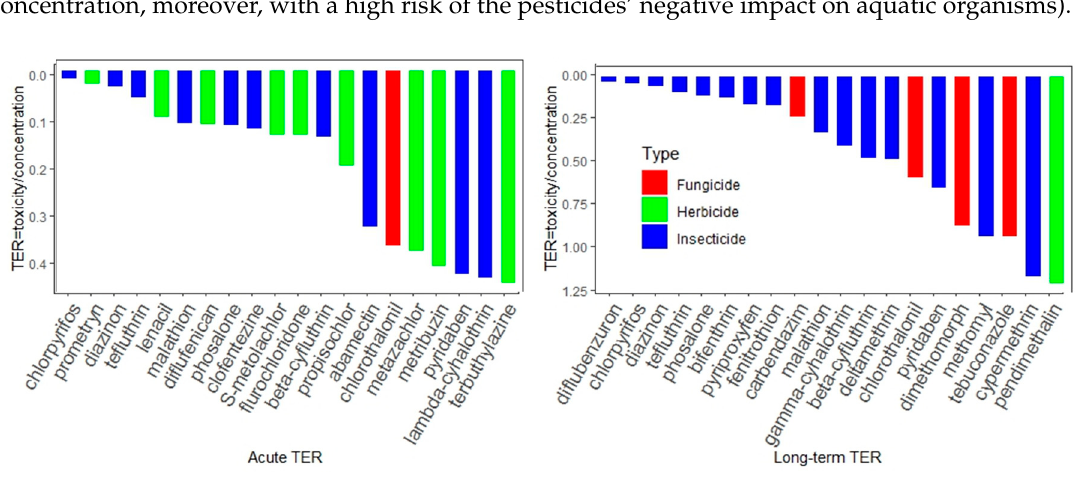
/ long-term TER for aquatic Figure 12. Ratings of the acute/long-term TER for aquatic organisms. Figure 12. Ratings of the acute